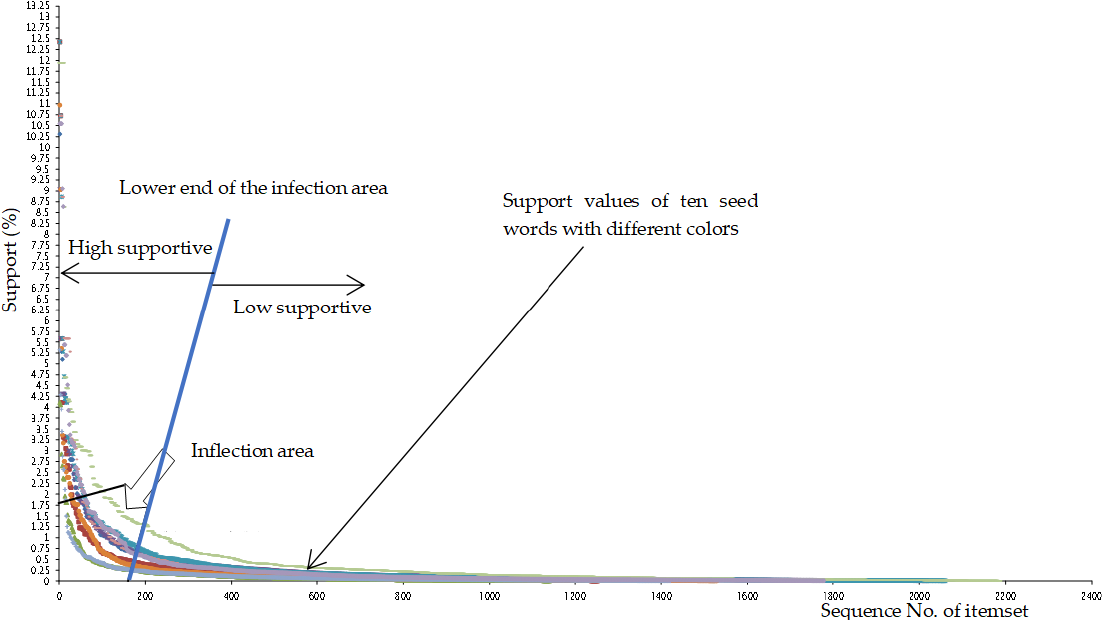
Figure 3. Distribution of support values.